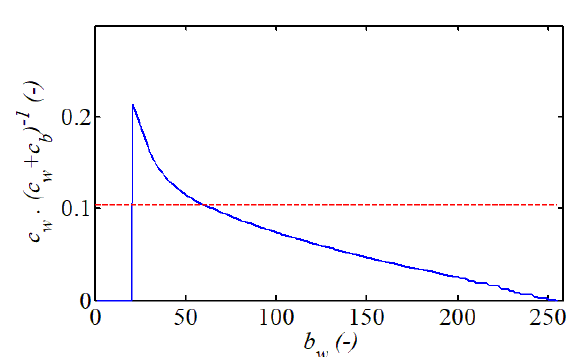
Fig. 6. Result of optimization for experiment No. 4. Blue line is the number of white particles during optimization, red doted line is the measured number of white .